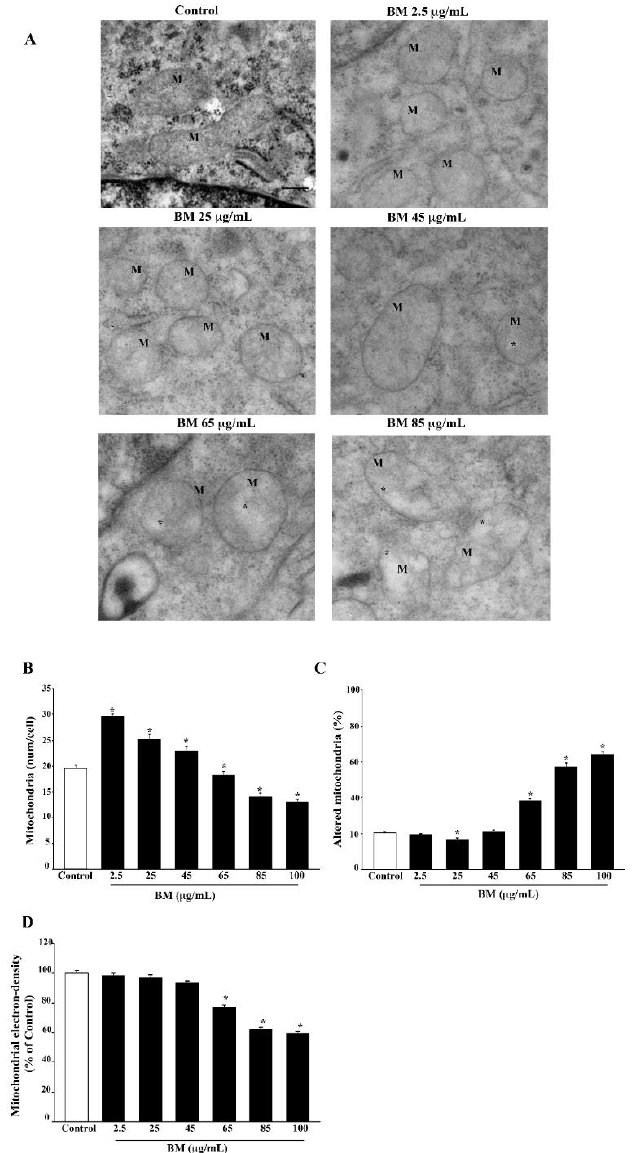
Figure 14. Effects of increasing doses of BM on mitochondrial ultrastructure. ( A ) Representative micrographs of mitochondria show that BM at low doses (i.e., 2.5 µ g/mL and 25 µ g/mL) preserves the ultrastructure of mitochondria, which appear with an electron-dense matrix and well conformed cristae. In contrast, at the highest doses used (ranging from 65 µ g/mL to 85 µ g/mL), BM induces mitochondrial alterations consisting of matrix dilution (*) and fragmented cristae. M = mitochondria. The graphs report the effects of increasing doses of BM on the number of total mitochondria per cell ( B ), the percentage of altered mitochondria per cell ( C ), the electron density of mitochondrial matrix ( D ). Values are given as the mean ± S.E.M. ( B ), mean percentage ± S.E.M. ( C , D ) of counts from three independent experiments. * p < 0.05 compared with controls. Scale bar = 230